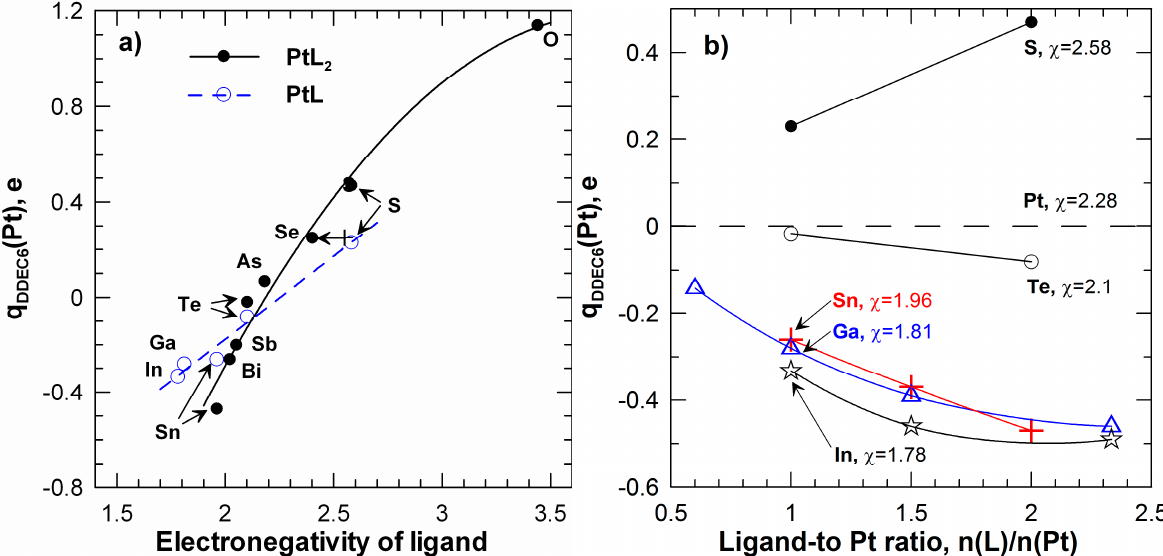
Figure 9. The partial atomic charges of Pt (DDEC6 method): a) calculated for PtL 2 and PtL compounds as a function of electronegativity of the ligand, b) calculated for compounds with different ligand-to-Pt ratio (PtS y , PtTe y , Pt x Sn y , Pt x Ga y , and Pt x In y ) as a function of the ratio. Symbols correspond to calculated values. In ( a ), the value of the electronegativity of Se was changed from 2.55 (cross, [3]) to 2.4 (closed circle, Pauling [35]). In ( b ), the ligand is indicated and the electronegativity of the ligand χ is given for each compound group.